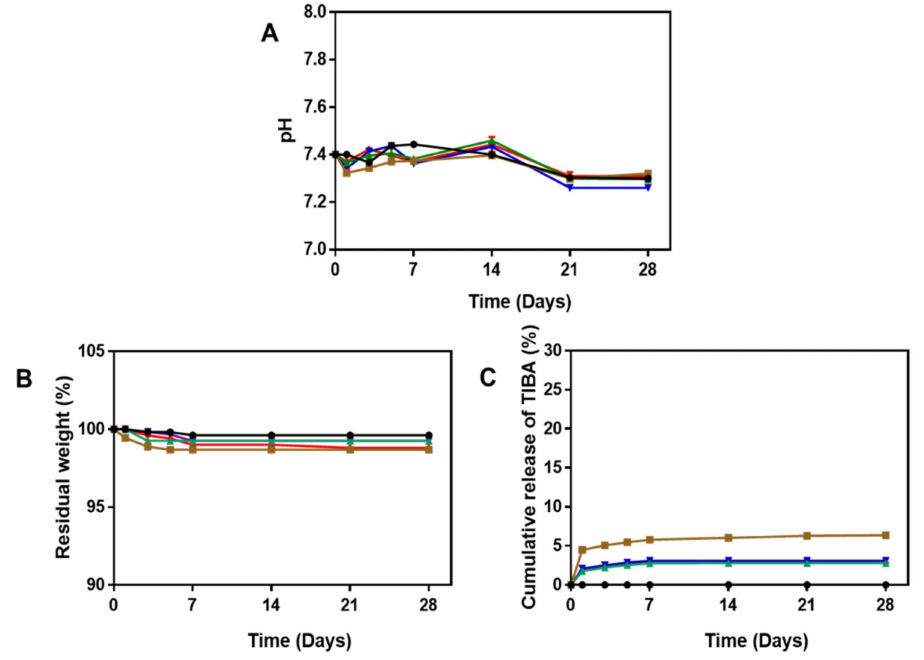
Figure 3. ( A ) The changes in pH, ( B ) residual weight (%), and ( C ) cumulative release of TIBA of the coated PLLA films during degradation in PBS solution at 37 ◦ C for 28 days, there was no significant difference between five groups. (PLLA